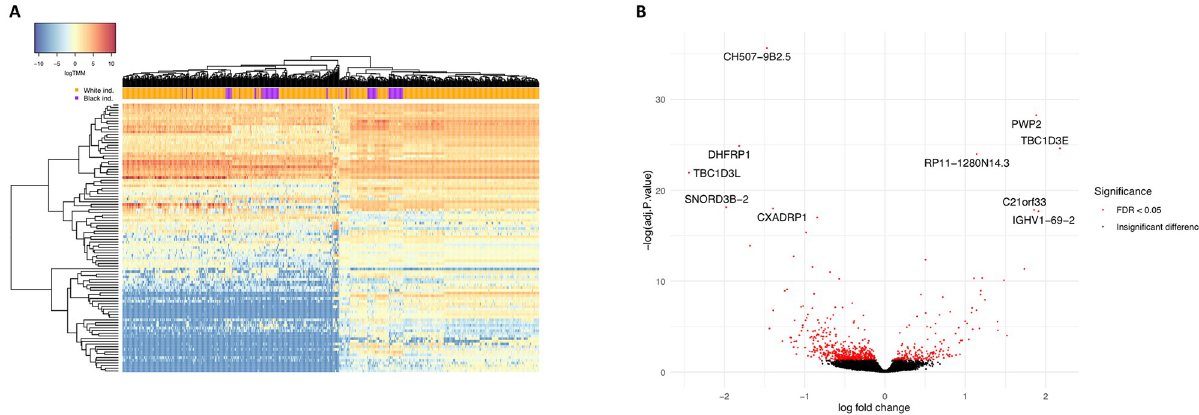
Fig 3. DEGs between Black and White individuals in whole blood. (A) Expression heatmap of the top 100 DEGs in 815 whole blood samples, showing the result of a two-way unsupervised hierarchical clustering. Each row represents a DEG and each column represents a sample. The order of genes and samples was determined in an unsupervised manner, based on similarities in expression profiles, and is detailed in S5 Table. Samples are color coded according to their reported race. Expression values are presented in log(TMM), scaled according to the color key in the top left corner. (B) Volcano plot depicting the magnitude and significance of expression differences at the single gene level. For each gene expressed in whole blood, the log 2 fold change of normalized expression between Black and White individuals is shown on the X axis, and the negative log 10 of its FDR-adjusted P value is shown on the Y axis. Positive X values represent upregulation in Black individuals and negative X values represent downregulation. Significant DEGs are in red and the symbols of the 10 most significant ones are noted. DEG, differentially expressed gene.